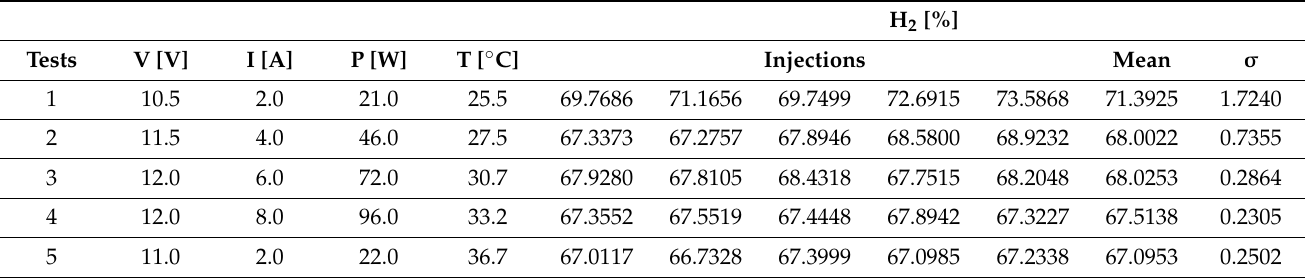
Table 5. Results of molar concentration in % of H 2 with 20% ( w/w ) of KOH.